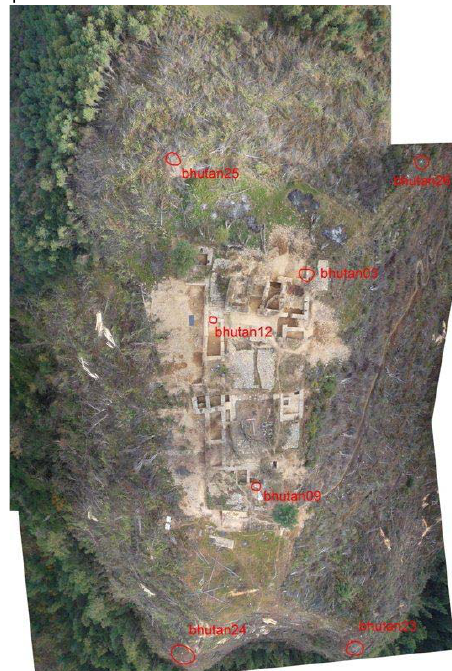
Figure 2: The distribution of ground control points on